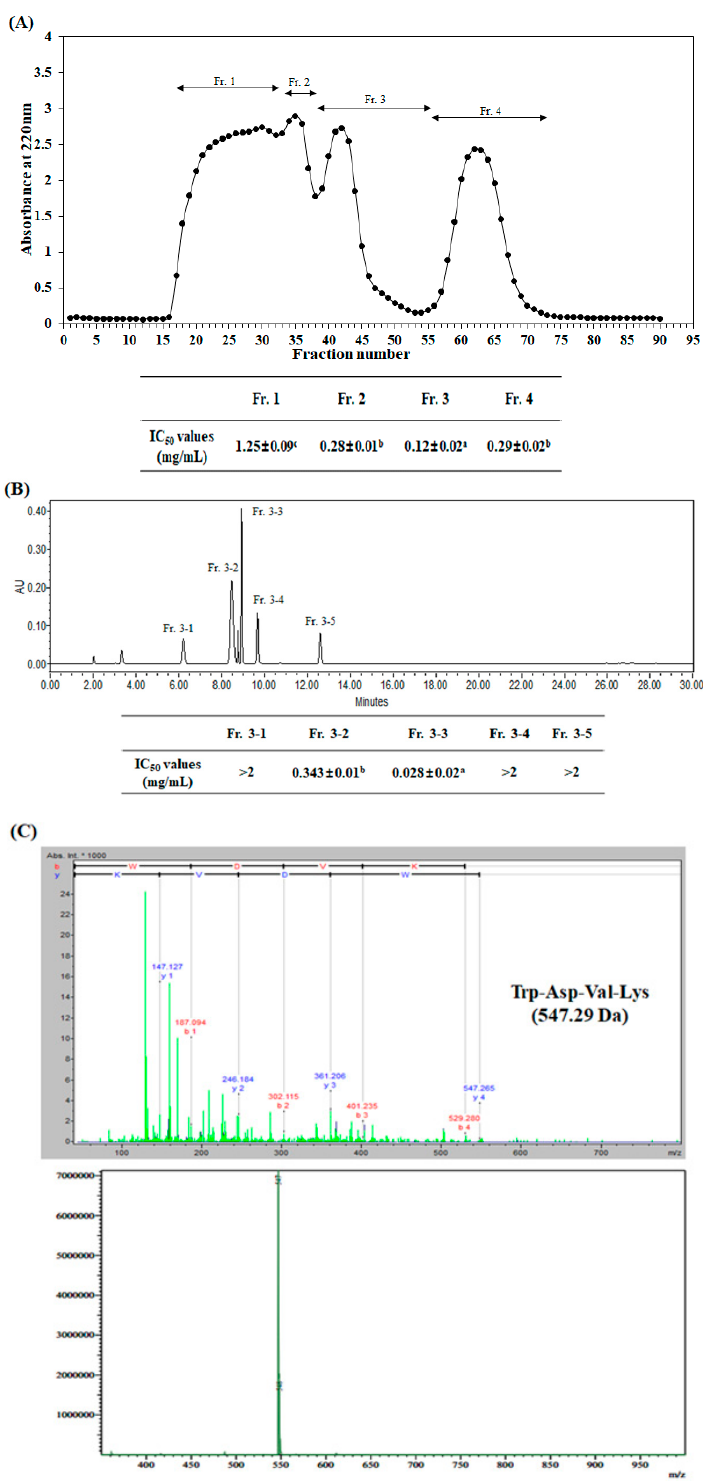
Figure 1. Purification and identification of antioxidant peptide. ( A ) Sephadex G-25 gel filtration chromatogram of <5 kDa fraction from Alcalase hydrolysate (upper panel) and its peroxyl radical scavenging activity (lower panel). ( B ) RP-HPLC chromatogram of the potent peroxyl radical scavenging activity fraction (Fr. 3) isolated from G-25 (upper panel) and its peroxyl radical scavenging activity (lower panel). ( C ) Identification of amino acid sequence and (left panel) molecular weight (right panel) of the purified peptide (TAVL) from Alcalase hydrolysate of velvet antler with a Q-TOF ESI mass spectrometer. These values are expressed as mean ± S.E. from triplicate experiments. a–c Values with different alphabets are significantly different at p < 0.05 as analyzed by Duncan’s multiple range test. Table 3. Comparison with peroxyl radical scavenging activity by the tetrapeptide (TAVL) and ascorbic acid. 51.16 ± 0.2 Ascorbic acid